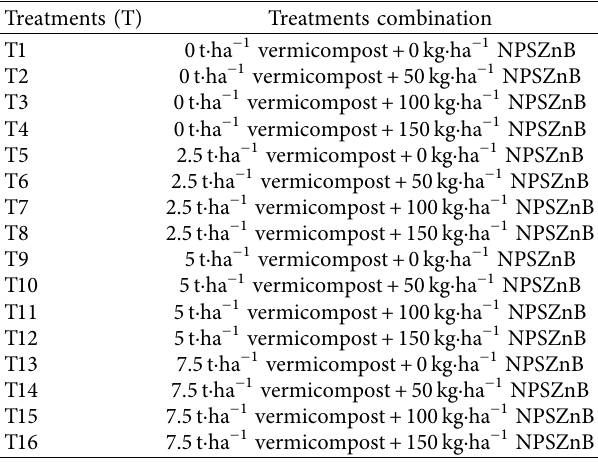
Table 2: Te treatment used for the experiment. Treatments (T) Treatments